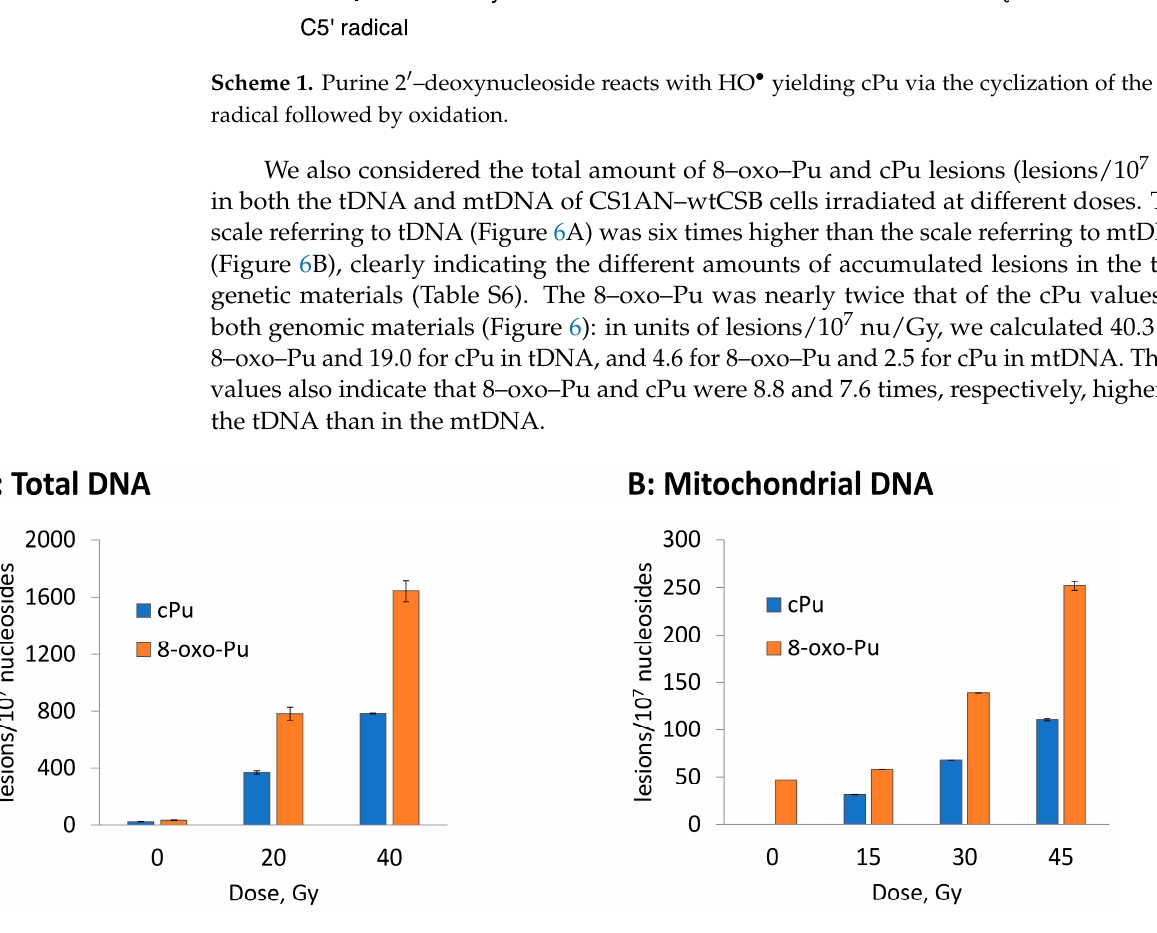
Figure 6. Total amount of cPu and 8–oxo–Pu lesions (lesions/10 7 nu) in irradiated samples of tDNA ( A ) and mtDNA ( B ). The numbers represent the mean value (± standard deviation) in tripli-